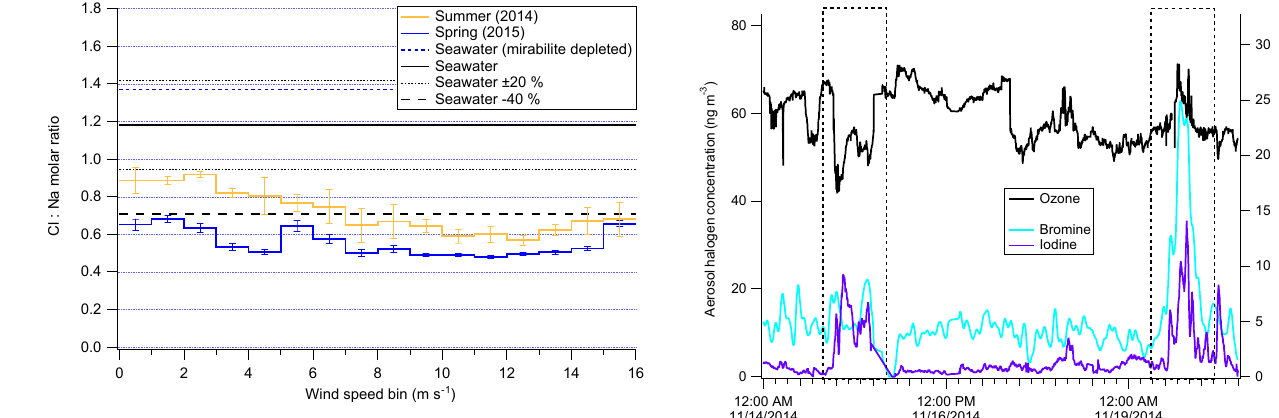
Figure 9. Cl : Na weight ratio as measured/modeled in the AMS as a function of wind speed for both overall field seasons. Error bars shown indicate standard error of the mean.